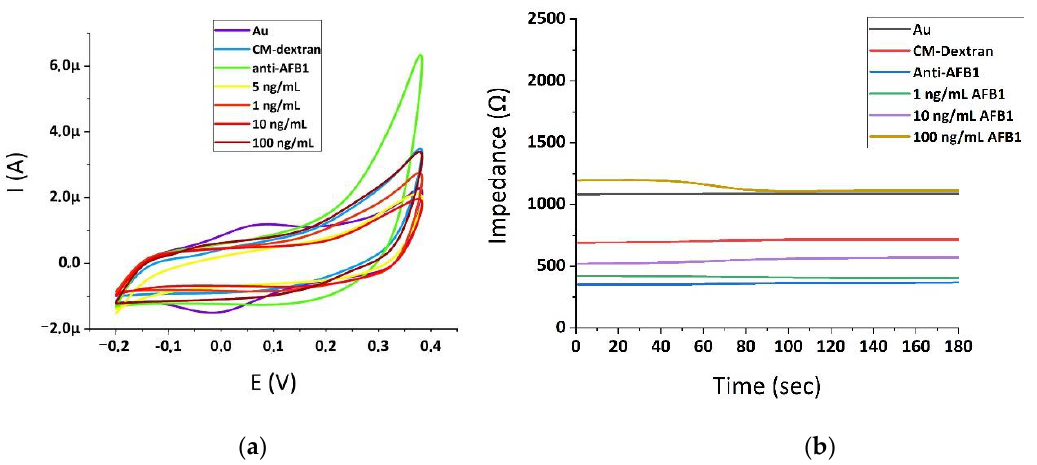
Figure 4. Cyclic voltammograms in acetate buffer (pH 5.6) recorded at a scan rate of 0.1 V/s after each step of the Au electrode’s modification ( a ). Impedance time series in acetate buffer (pH 5.6) after each step of the Au electrode’s modification ( b ).